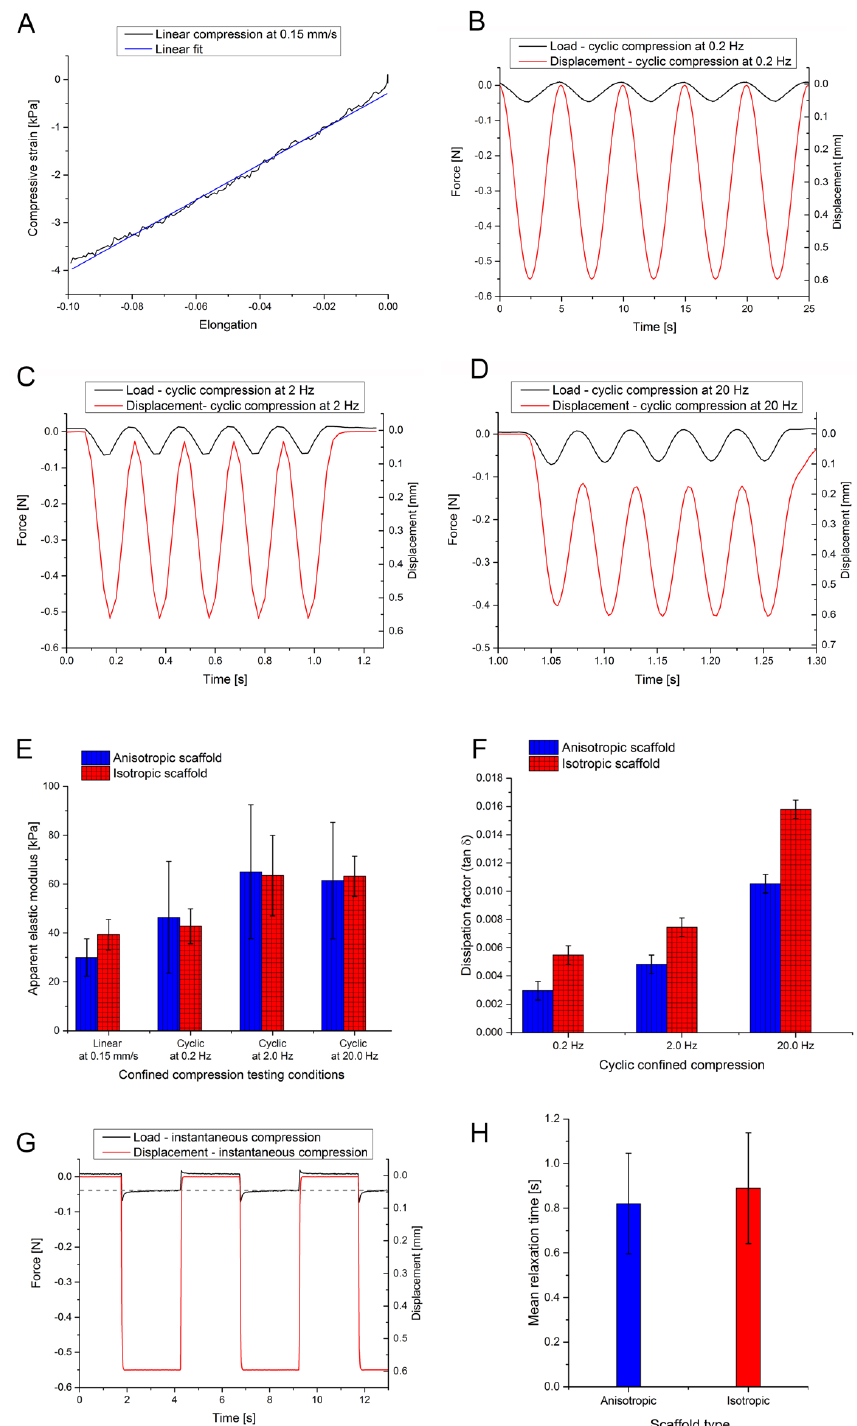
Figure 3. ( A ) Exemplary datasets of linear compression with a crosshead speed of 0.15 mm / s; Figure 3. A , Exemplary datasets of linear compression with a crosshead speed of 0.15 mm/s; B – D , ( B – D ) Cyclic compression with 0.2, 2, and 20 Hz for a bone sca ff old with isotropic pore structure; Cyclic compression with 0.2, 2, and 20 Hz for a bone scaffold with isotropic pore structure; E , ( E ) Resulting apparent elastic modulus for linear and cyclic compression; ( F ) Dissipation factor for Resulting apparent elastic modulus for linear and cyclic compression; F , Dissipation factor for linear linear and cyclic compression. Testing parameters: 0.15 mm / s, 0.2 Hz, 2 Hz, and 20 Hz respectively; and cyclic compression. Testing parameters: 0.15 mm/s, 0.2 Hz, 2 Hz, and 20 Hz respectively; error error bars were derived by error propagation; ( G ) Exemplary dataset of instantaneous deformation by square function; ( H ) Mean relaxation time of tested sca ff olds. Error bars represent standard